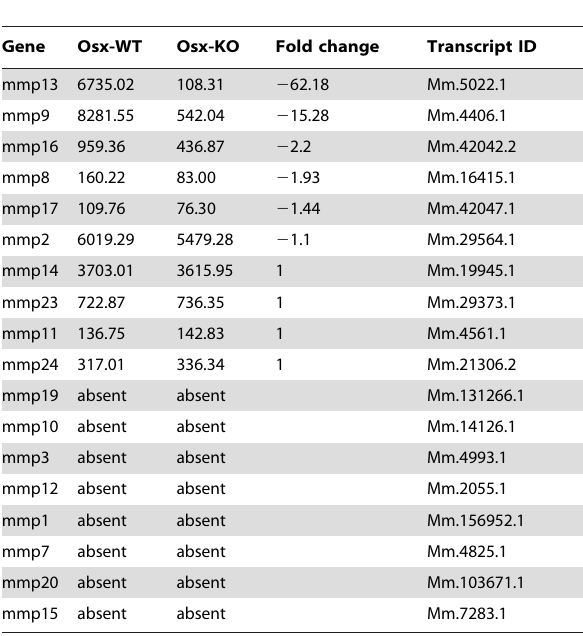
Table 1. Effect of Osx on MMP family member